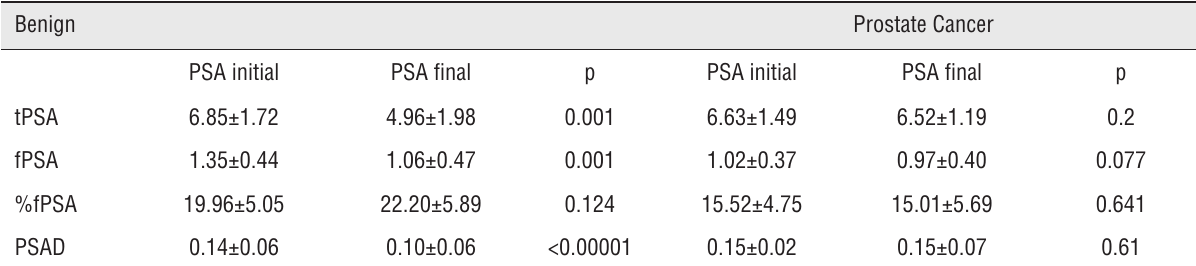
PSAD 0.61 Values expressed in mean±standard variation. Student t